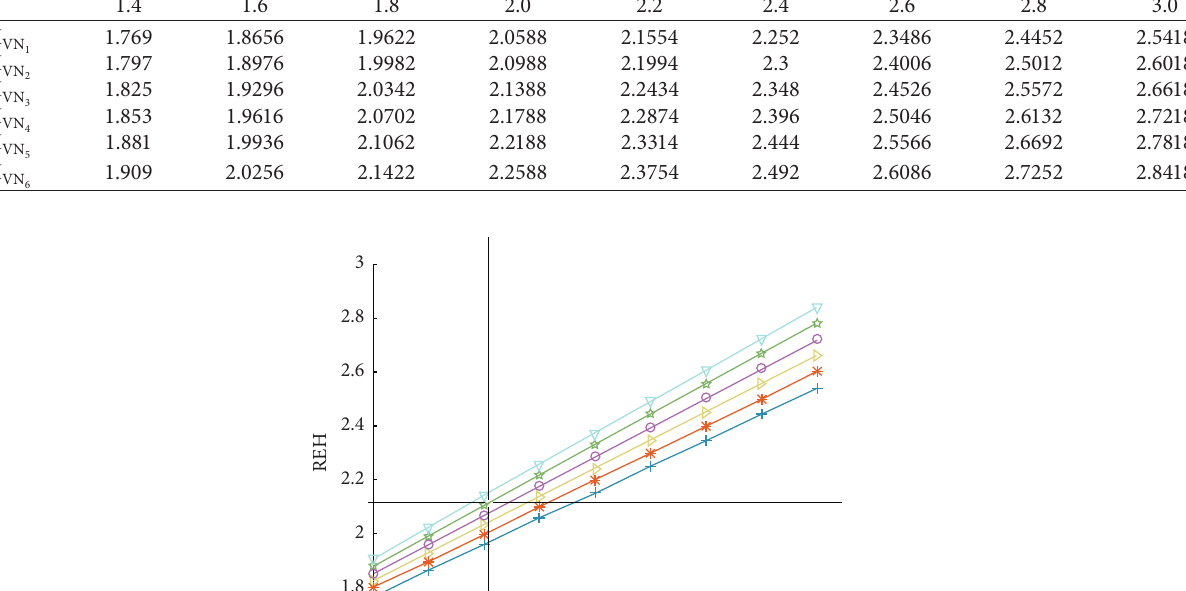
Table 7: Values calculated under different higher education costs (REH